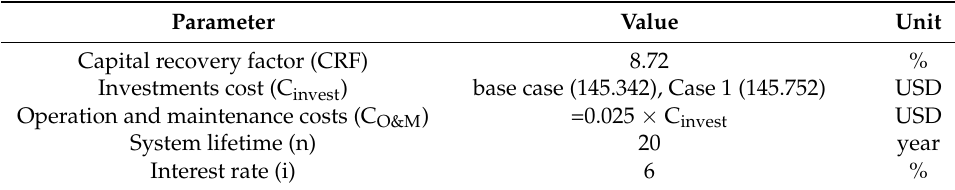
Figure 8. Variations of the LCE with flow rates at the inlet temperature of 20 °C. Table 8. Parameters used for the LCE calculation.